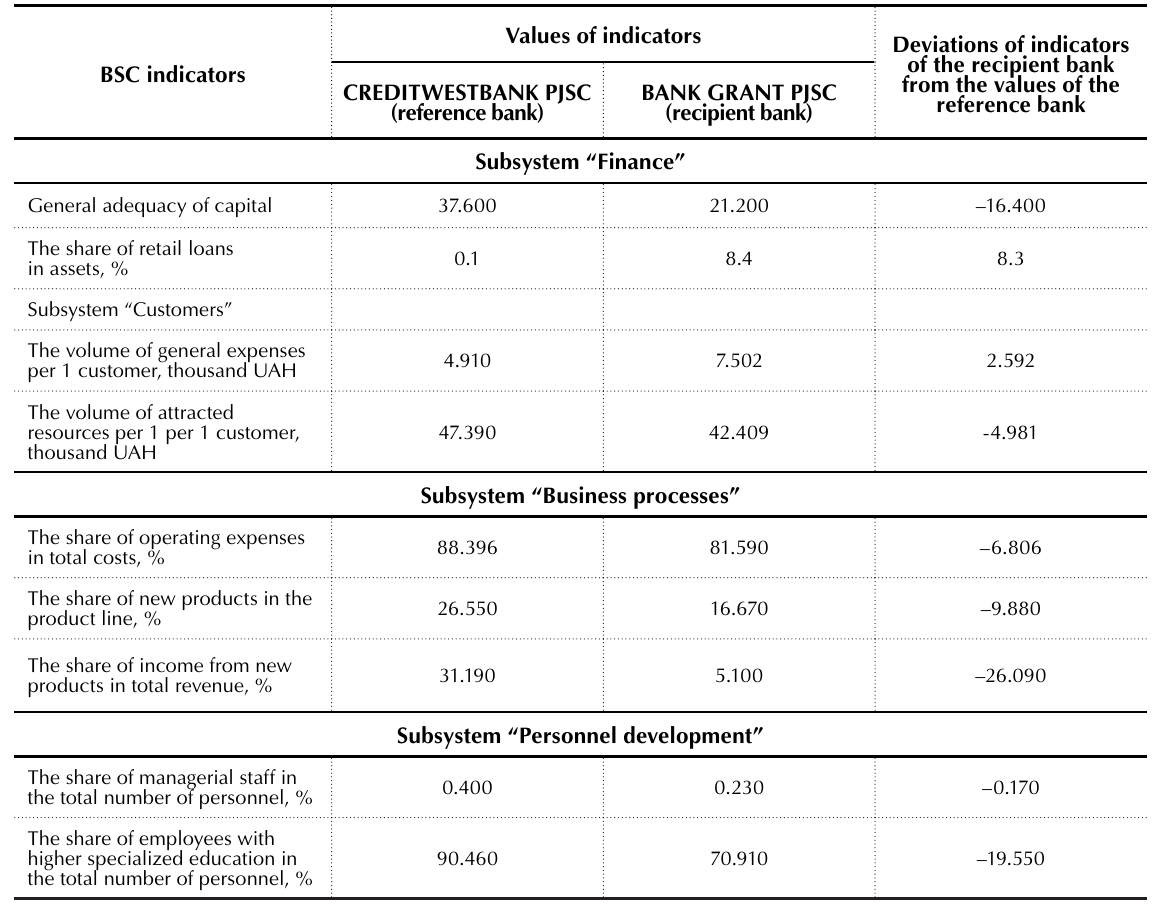
Table 2. Comparable indicators of the reference bank and the recipient bank